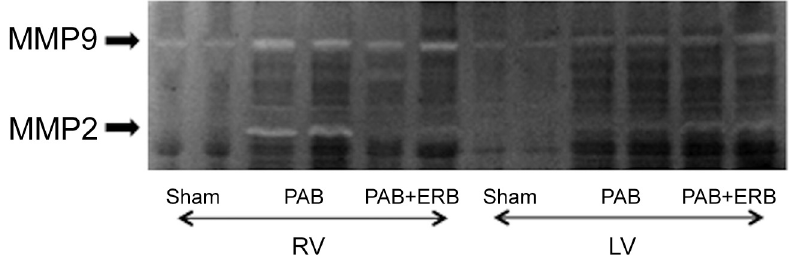
Fig 5. Zymographic image of activated MMP-2 and MMP-9. Representative MMP-9 and MMP2 activity in RV and LV of sham using zymography. Results corresponds with western blot results, showing activated MMP-9 and MMP-2 up regulated in PAB compare with sham; and down regulated after ERB treatment compare with PAB in the RV, but less in the